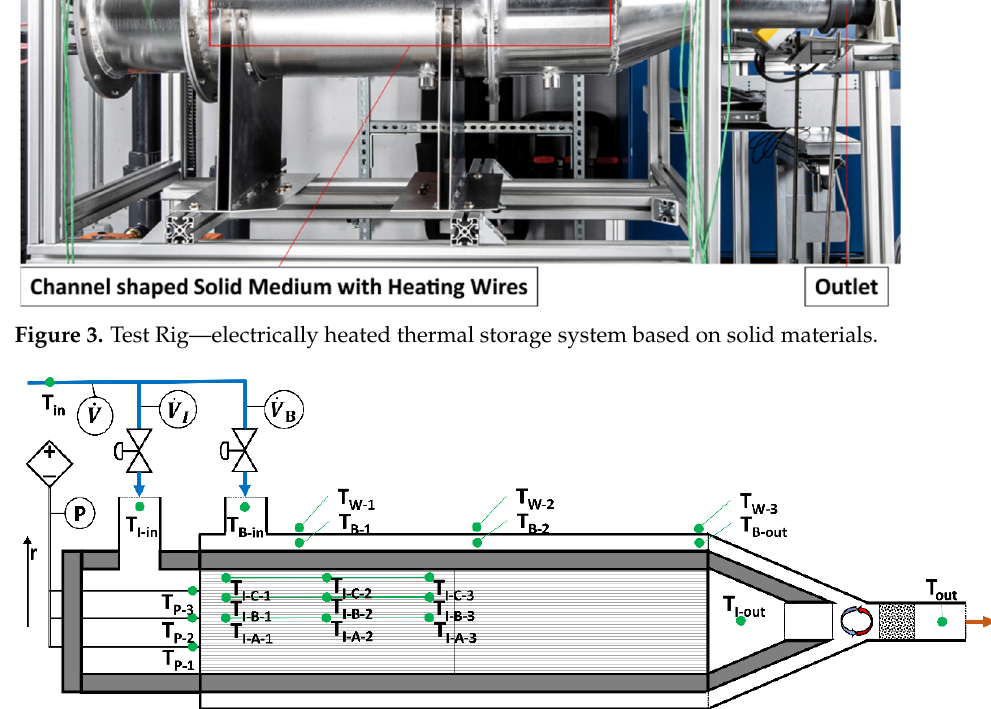
Figure 3. Test Rig—electrically heated thermal storage system based on solid materials.